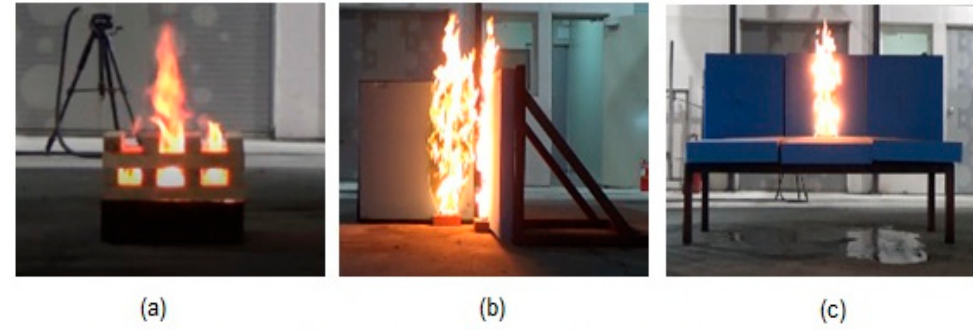
Figure 1. Independent measurement of heat release rate for ( a ) the wood crib, ( b ) polyurethane foam (PUF), and ( c ) the sofa model.